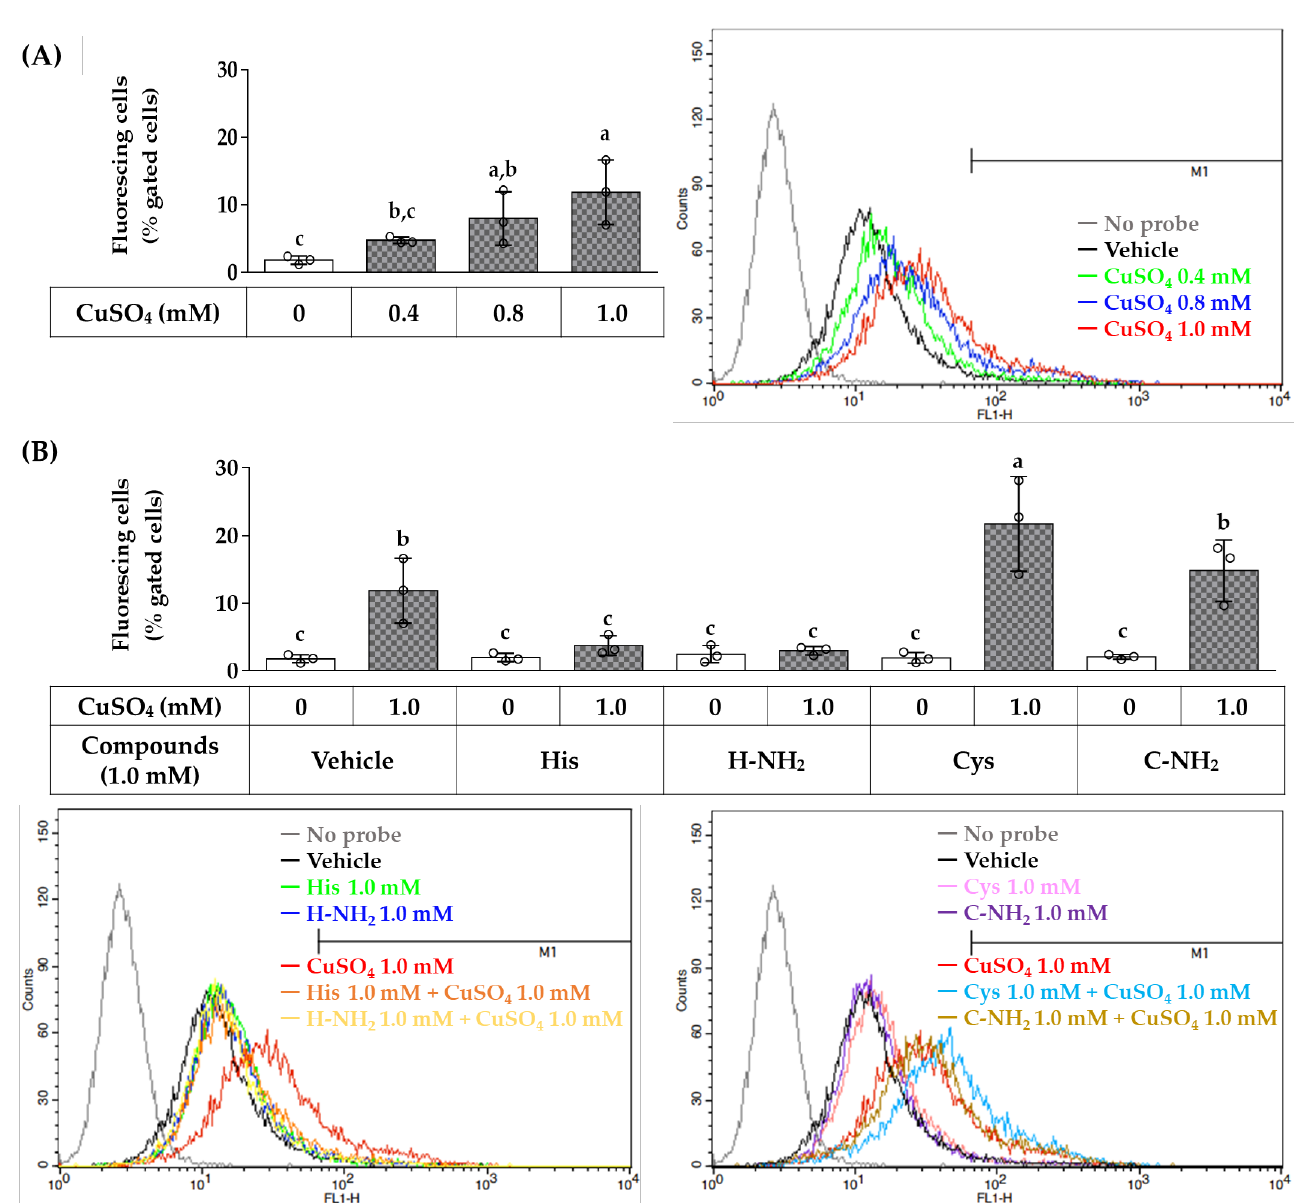
Figure 5. Flow cytometry for the assay of intracellular reactive oxygen species (ROS) production in HaCaT cells exposed to CuSO 4 in the absence and presence of histidine, histidinamide, cysteine, or cysteinamide. In ( A ), cells were treated with CuSO 4 at different concentrations for 3 h. In ( B ), cells were treated with vehicle or amino acid analog at 1.0 mM alone or in combination with 1.0 mM CuSO 4 for 3 h. The treated cells were washed with phosphate-buffered saline (PBS), labeled with 2′,7′-dichlorodihydrofluorescein diacetate (DCFH-DA) for 30 min, and suspended in PBS for flow cytometric analysis. Typical flow cytometry histograms are shown. M1 in the histogram denotes the fluorescing cells. The ratios (%) of fluorescing cells to the total gated cells are presented (mean ± SD, n = 3). Different lowercase letters (a–c) indicate significantly different means at the p < 0.05 level.